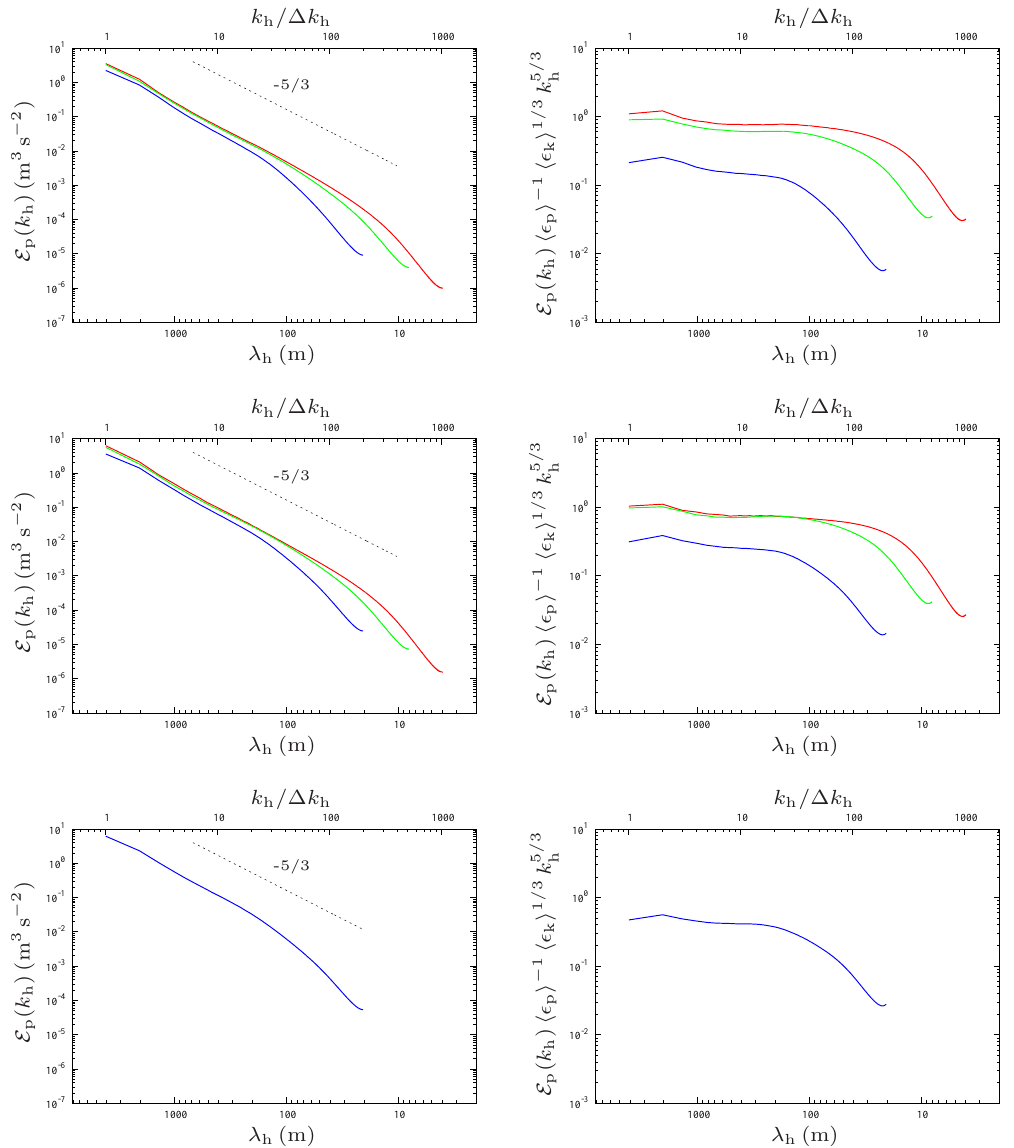
Figure 14. Horizontal turbulent potential energy spectra (left panels) and compensated spectra (right panels). From top to bottom: strong forcing, moderate forcing, and weak forcing cases. Red lines: 1 = 2m; green lines: 1 = 4m; blue lines: 1 =